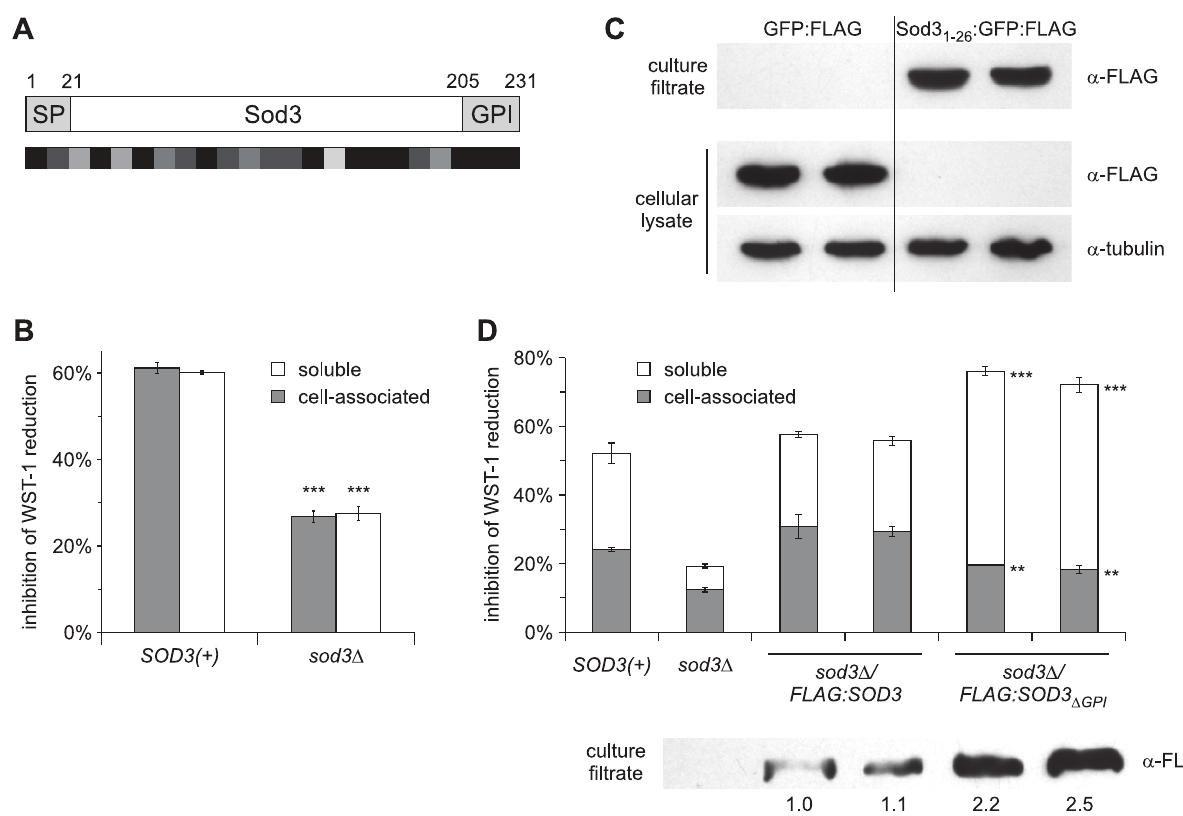
Figure 2. N-terminal and C-terminal signals direct extracellular localization of Sod3. ( A ) Schematic of the Sod3 protein highlighting the predicted signal peptide (SP) and the glycophosphatidyl inositol anchor (GPI) signal motifs. Numbers represent amino acid residues in the Sod3 protein. Shading beneath the Sod3 protein indicates amino acid sequence similarity between G186A, G217B and NAm1 Sod3 proteins ranging from dark ( . 90% sequence identity) to light ( , 50% identity). ( B ) Relative Sod3 activity associated with the yeast cell and soluble extracellular fraction. Superoxide dismutase activities were determined by inhibition of superoxide-dependent WST-1 reduction in the presence of 1 6 10 8 yeasts (cell- associated) or the corresponding culture filtrate (soluble) of SOD3( + ) (OSU45) and sod3 D (OSU15) strains (n=3, each). Inhibition of WST-1 reduction was normalized to reactions in the absence of yeasts or culture filtrate. Asterisks represent significant differences (p , 0.001) from SOD3( + ) samples. ( C ) Determination of the localization of GFP when fused to the N-terminus of Sod3. Extracellular or intracellular GFP localization was determined by a - FLAG immunoblot of culture filtrates or cellular lysates from Histoplasma yeast strains expressing FLAG epitope-tagged GFP (GFP:FLAG; OSU88) or GFP with the first 26 amino acids of Sod3 (Sod3 1–26 :GFP:FLAG; OSU102). Cellular lysates were also tested for a -tubulin to demonstrate equal loadings. ( D ) Localization of Sod3 activity after removal of the C-terminal 26 amino acids. Cell-associated and soluble superoxide dismutase activities of Histoplasma yeasts were determined using 1 6 10 8 intact yeasts or their corresponding culture filtrates, respectively. Samples were collected from SOD3( + ) (OSU45), sod3 D (OSU15), and yeasts expressing full length Sod3 ( sod3 D /FLAG:SOD3 ; OSU116) or Sod3 lacking the putative GPI signal (sod3 D / FLAG: SOD3 D GPI ; OSU117). Results were normalized to uninhibited reactions and plotted as the proportion of total inhibitory activity. Asterisks represent significant difference from full length Sod3 (** p , 0.01, *** p , 0.001). Relative quantitation of Sod3 in culture filtrates was determined by a - FLAG immunoblot and is indicated numbers below.